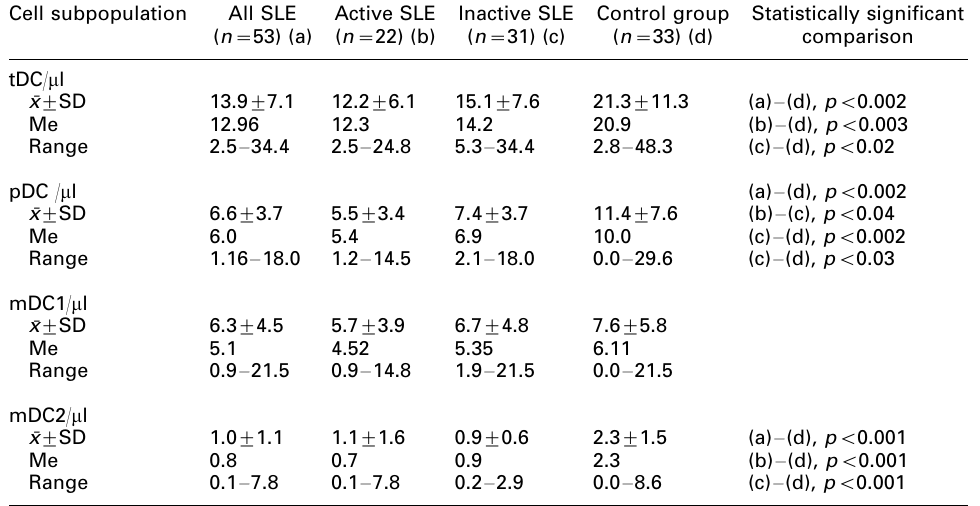
Table 2. Analysis of peripheral blood dendritic cells in patients with SLE and healthy donors (cell u m l) Cell subpopulation Control group